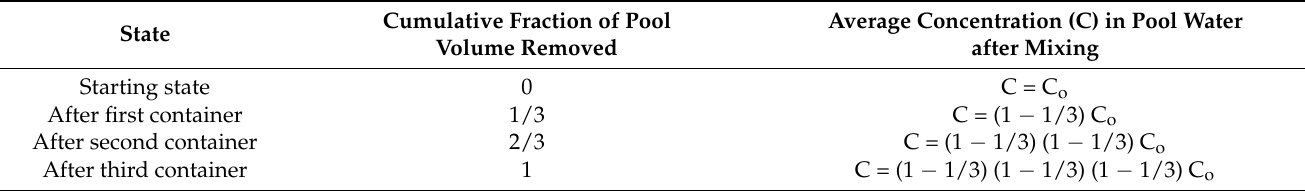
Average Concentration (C) in Pool Water after Mixing